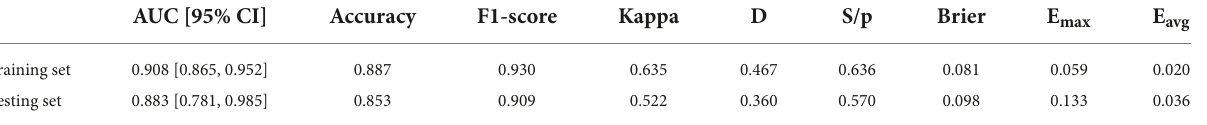
TABLE 3 Quantitative analysis of nomogram model both in the training and testing